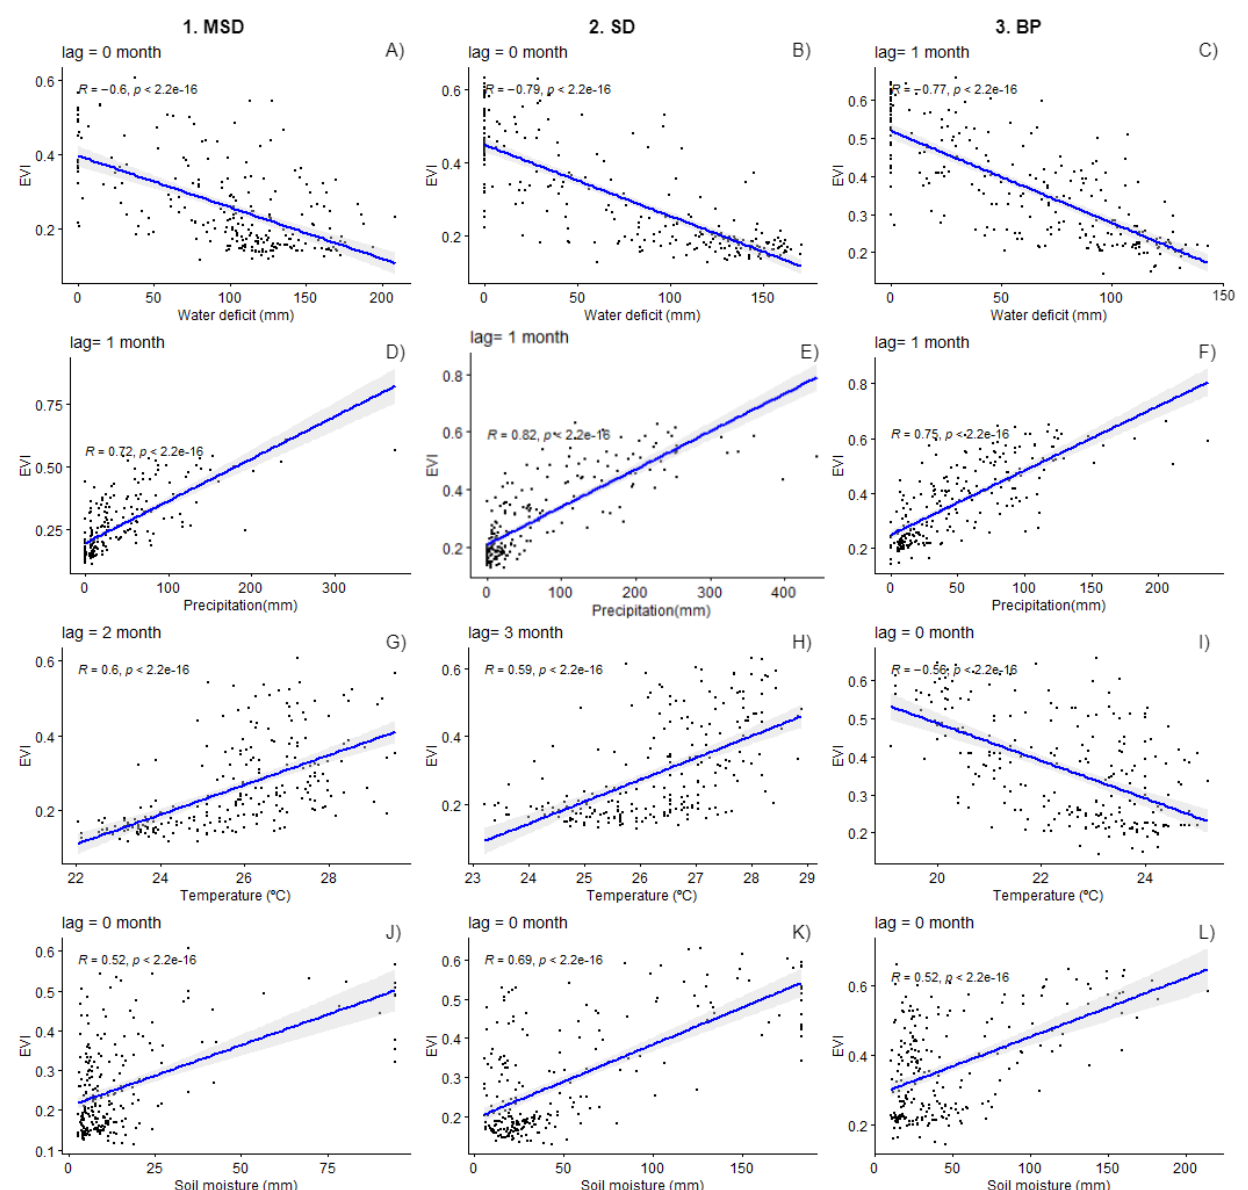
Figure 7. Correlation between EVI and environment drivers for MSD, SD, and BP in water deficit ( A – C ), precipitation ( D – F ), air temperature ( G – I ), and ( D ) Soil moisture ( J – L ). The lag months have the highest (r 2 ) between the environmental drivers and the EVI monthly time series.